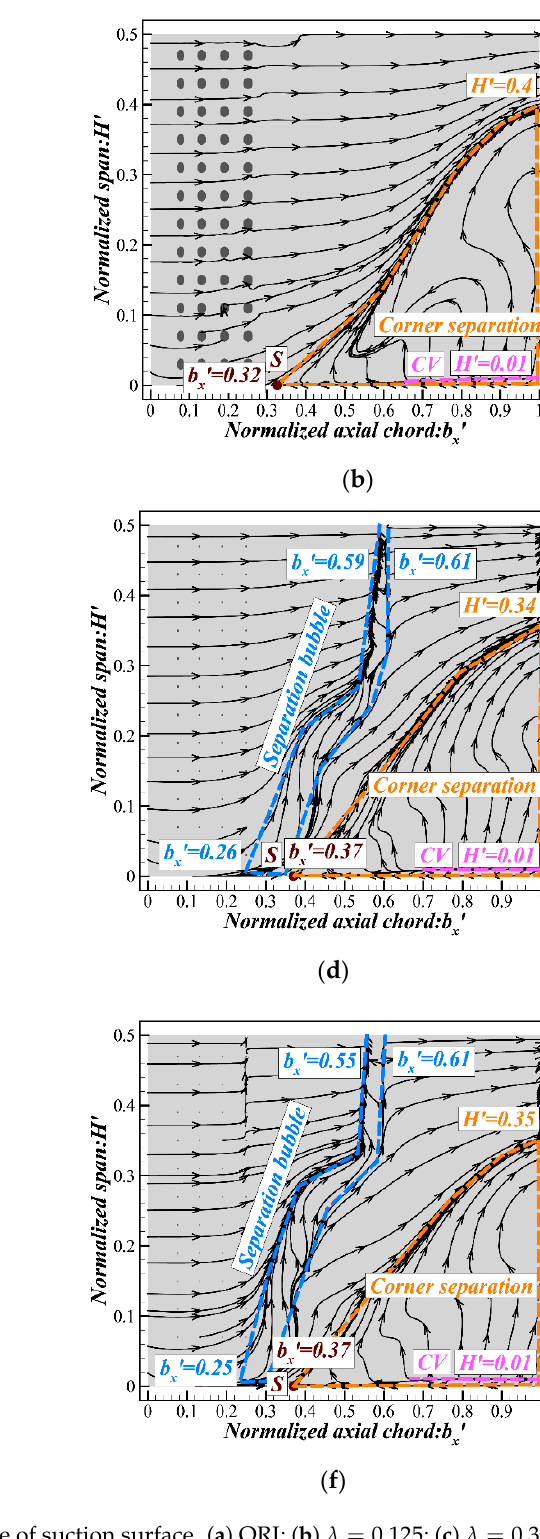
Figure 13. Limiting streamline of suction surface. ( a ) ORI; ( b ) 𝜆 = 0.125 ; ( c ) 𝜆 = 0.375 ; ( d ) 𝜆 = 0.5 ; ( e ) 𝜆 = 0.625 ; ( f ) 𝜆 = 0.875 .